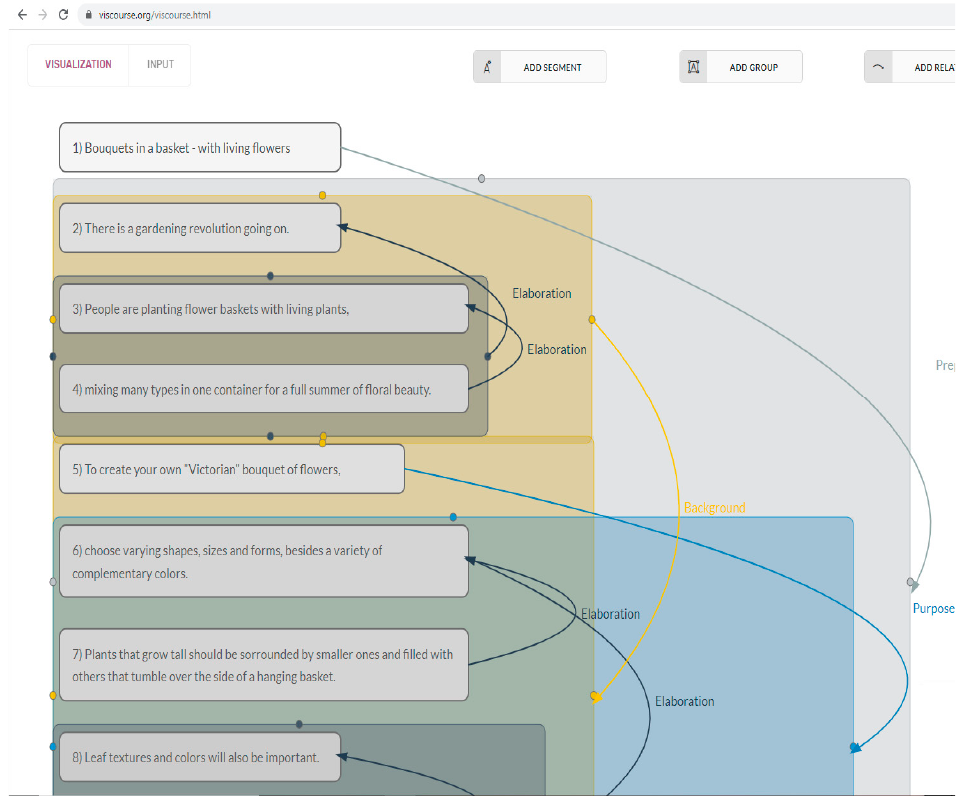
Figure 2. Viscourse textual analysis for the “Bouquets in a basket” Rhetorical Structure Theory (RST) corpus text.